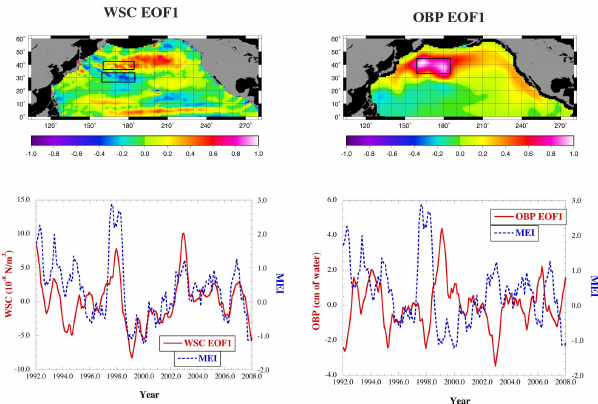
Fig. 2. Leading EOFs (top) and principal components (bottom) of WSC from CCMP (left) and OBP from OMCT (right). The EOFs have been normalized, so that the spatial patterns have a maximum of ± 1 and the principal components represent the magnitude of vari- ability. Data were low-pass filtered to isolate non-seasonal, low- frequency variations as described in Sect. 2, and the EOFs were computed using only data north of the equator in the Pacific and excluding coastal regions for OBP. The MEI is also shown for com- parison to the principal components. Boxes indicate areas where data are averaged for further comparison. See text for